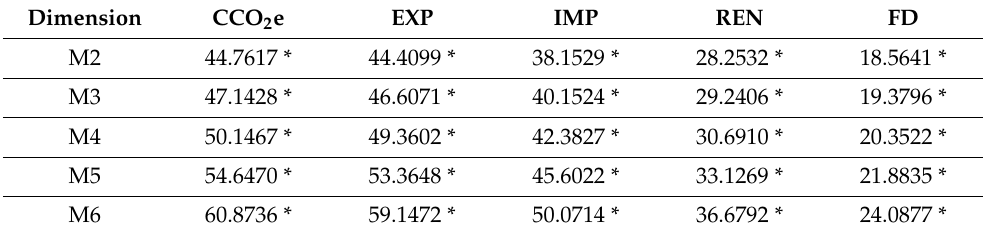
Table 4. BDS test.